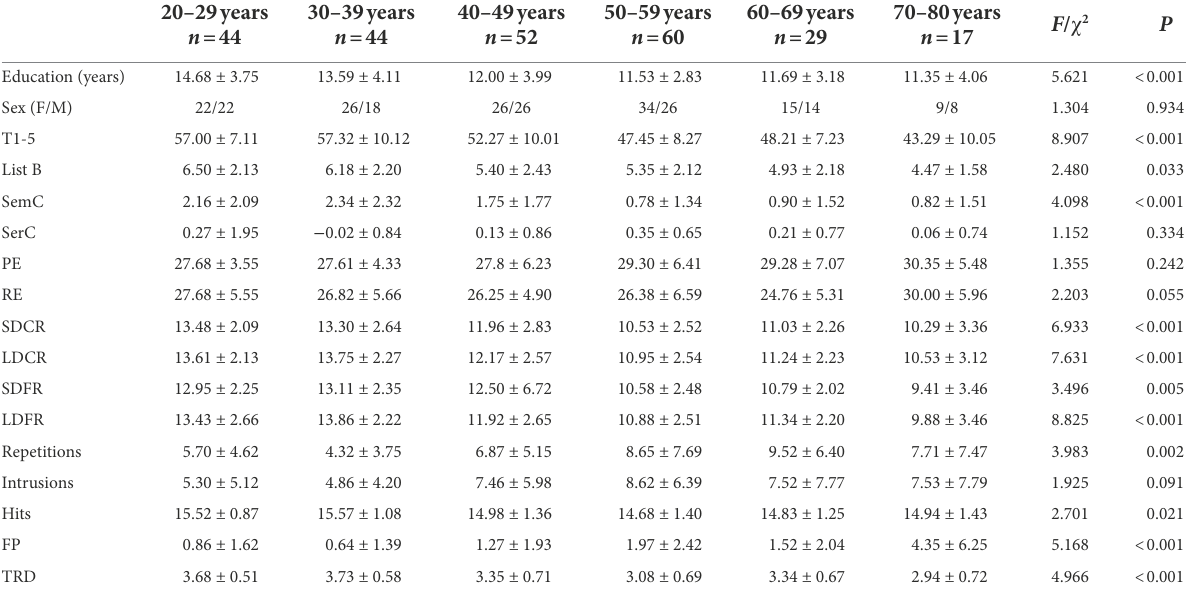
TABLE 2 California Verbal Learning Test-Second Edition (CVLT-II) factors in different age groups.